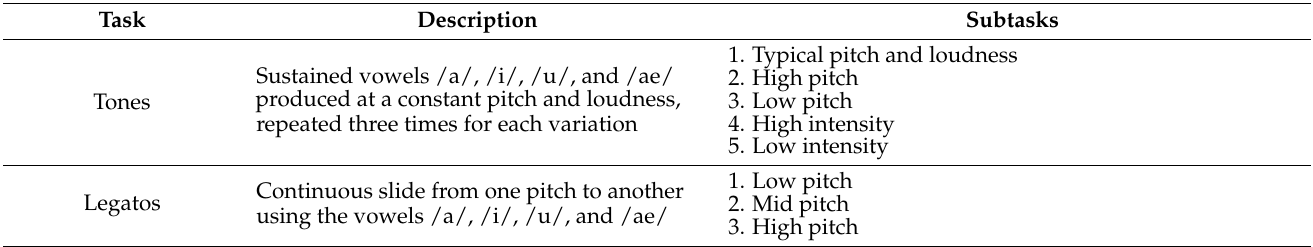
Table A1. Overview of speech tasks. Task Description